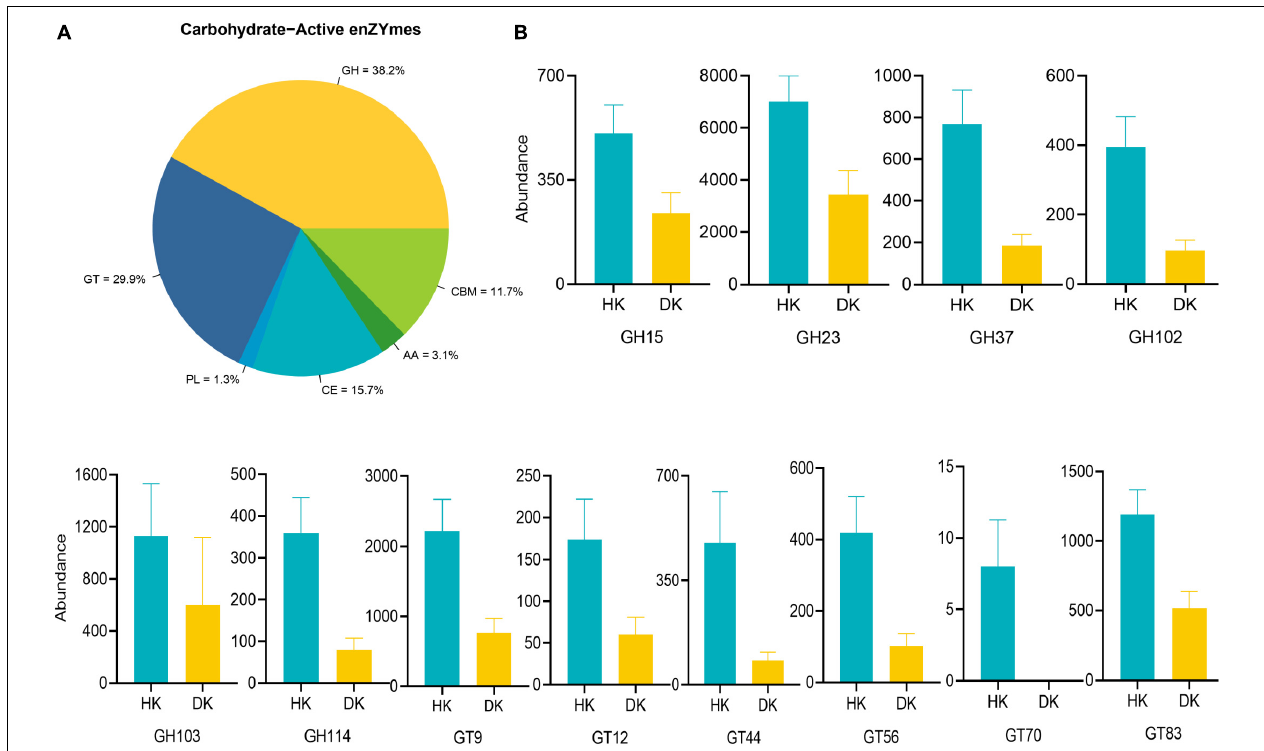
FIGURE 5 | Comparisons of the total abundance of CAZyme genes of fecal microbiomes of goat kids. (A) Carbohydrate enzyme distribution scale diagram. Colors indicate functional categories. (B) Comparisons of the relative abundance of the CAZyme gene families of the fecal microbiomes of goat kids in the diarrheic and healthy goat kids, and data represent mean values ± standard error of mean (SEM) ( P < 0.05, n =